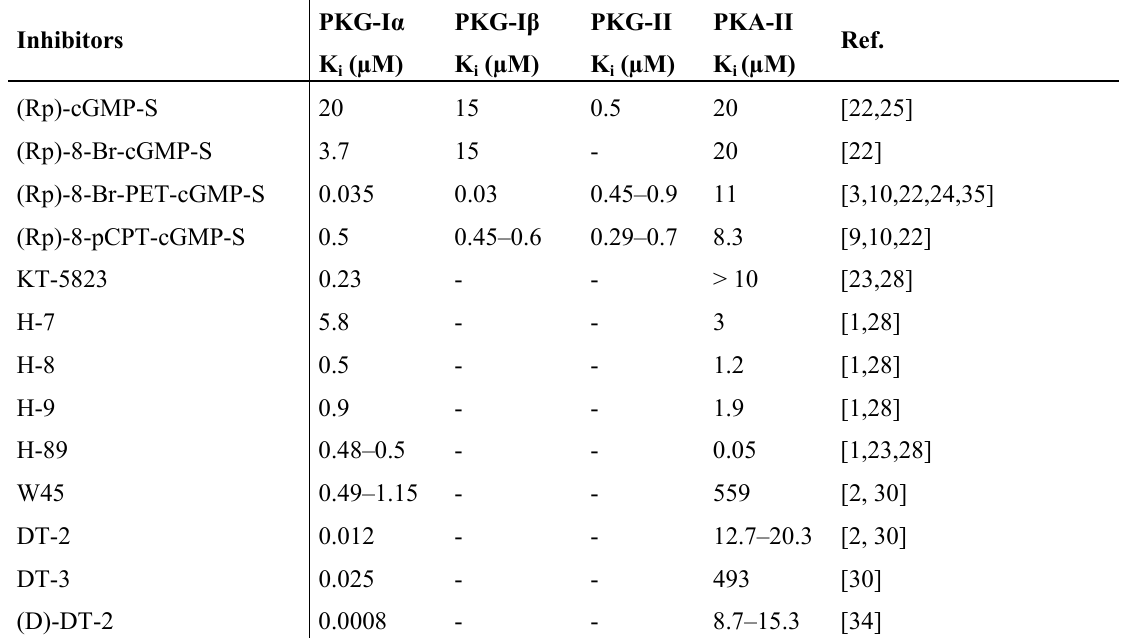
Table 1. Inhibition constants (K constants for kinases PKG-I α , -I β and -II and PKA were determined in vitro.